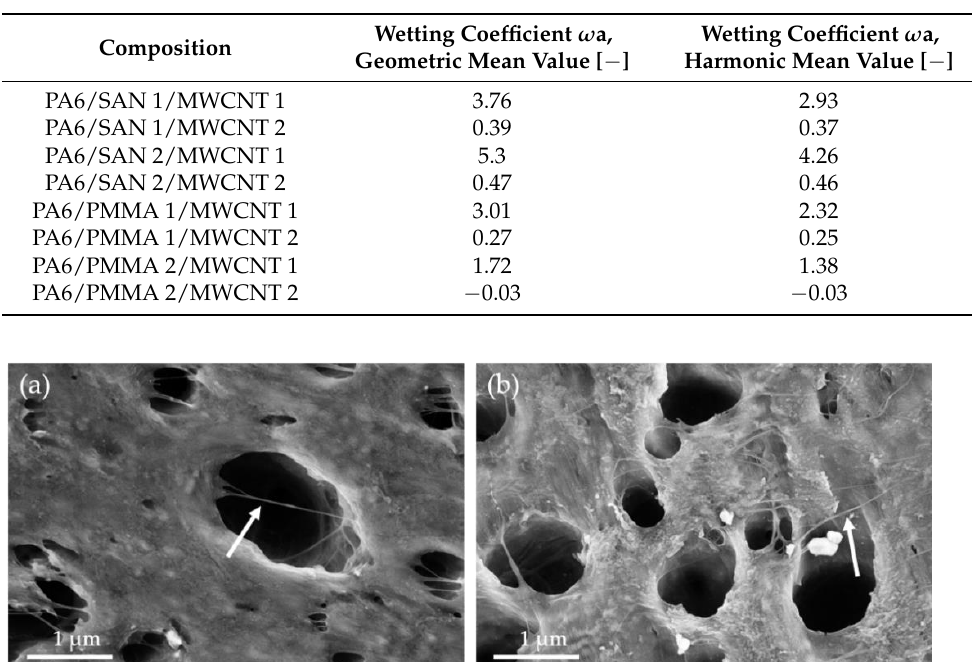
Table 5. Wetting coefficients as calculated using harmonic and geometric mean equations.